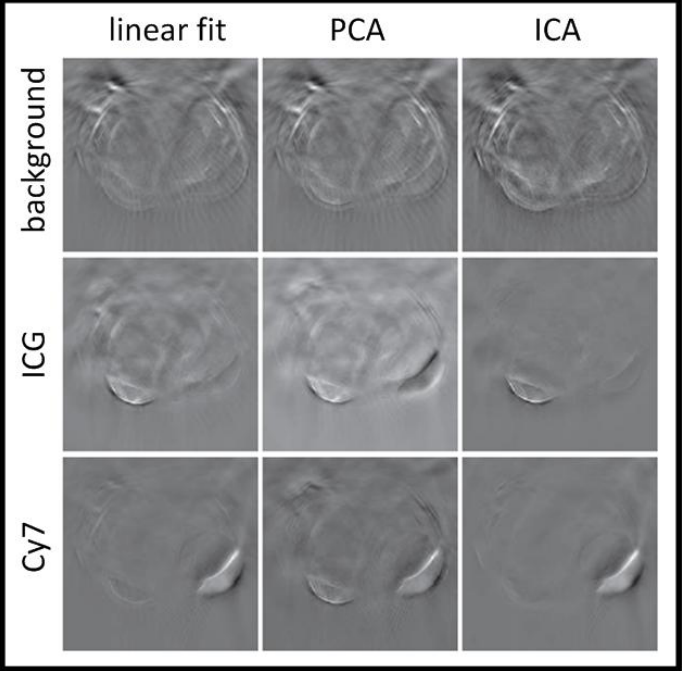
Figure 11. Comparison of the unmixing performance for different algorithms by Glatz et al. [156]. They implanted two insertions containing ICG and Cy7 in the neck area of an euthanized mouse and imaged the region multispectrally. The rows (top to bottom) show the components corresponding to background, ICG and Cy7, respectively. The columns show (left to right) the performance of linear fitting from known spectra and of blind methods with a PCA and an ICA algorithm, respectively. Reprinted with permission from Optical Society of America